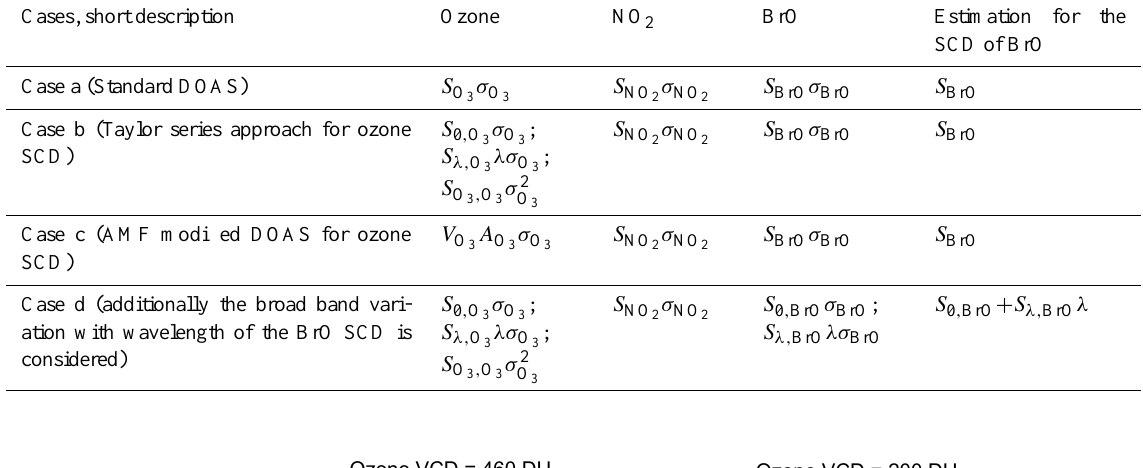
Table C1. Fit terms describing the trace gas absorptions for different approaches in the DOAS fit and equations for the estimation of the BrO SCD from the fitted coefficients.